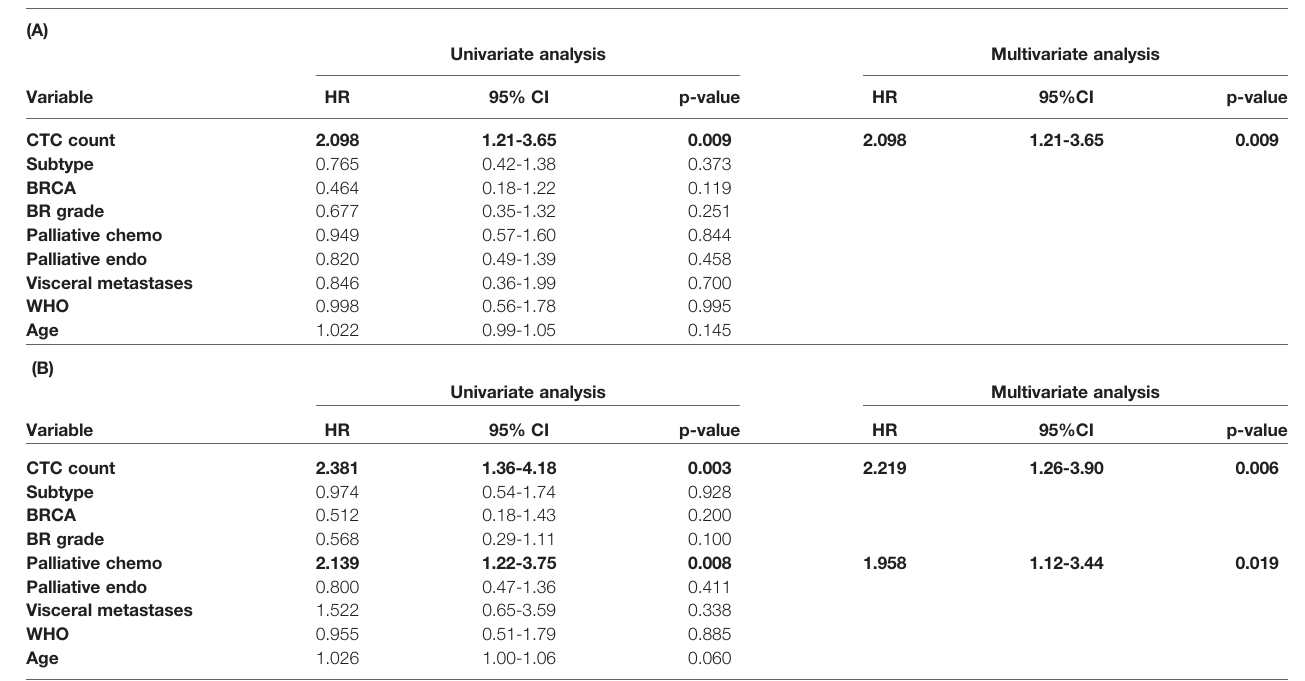
Supplementary Table 3 . Of the 119 reported SAEs, only 12 of the SAEs (10%) were grade 3 or higher and related to cDDP treatment.